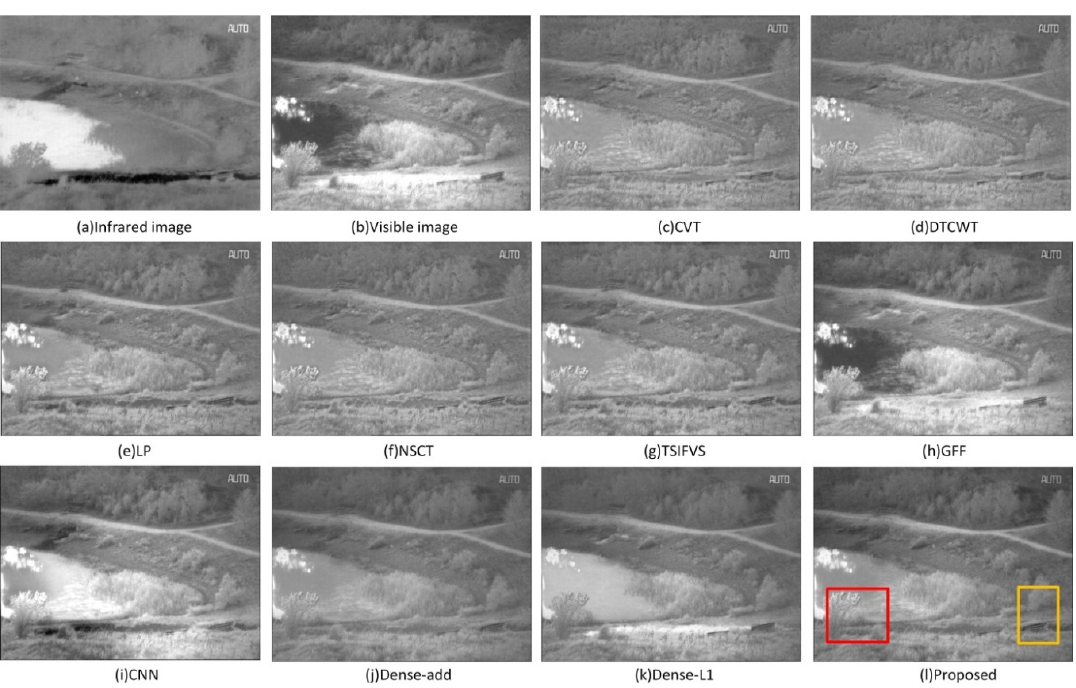
Figure 9. Fused images of “lake”.